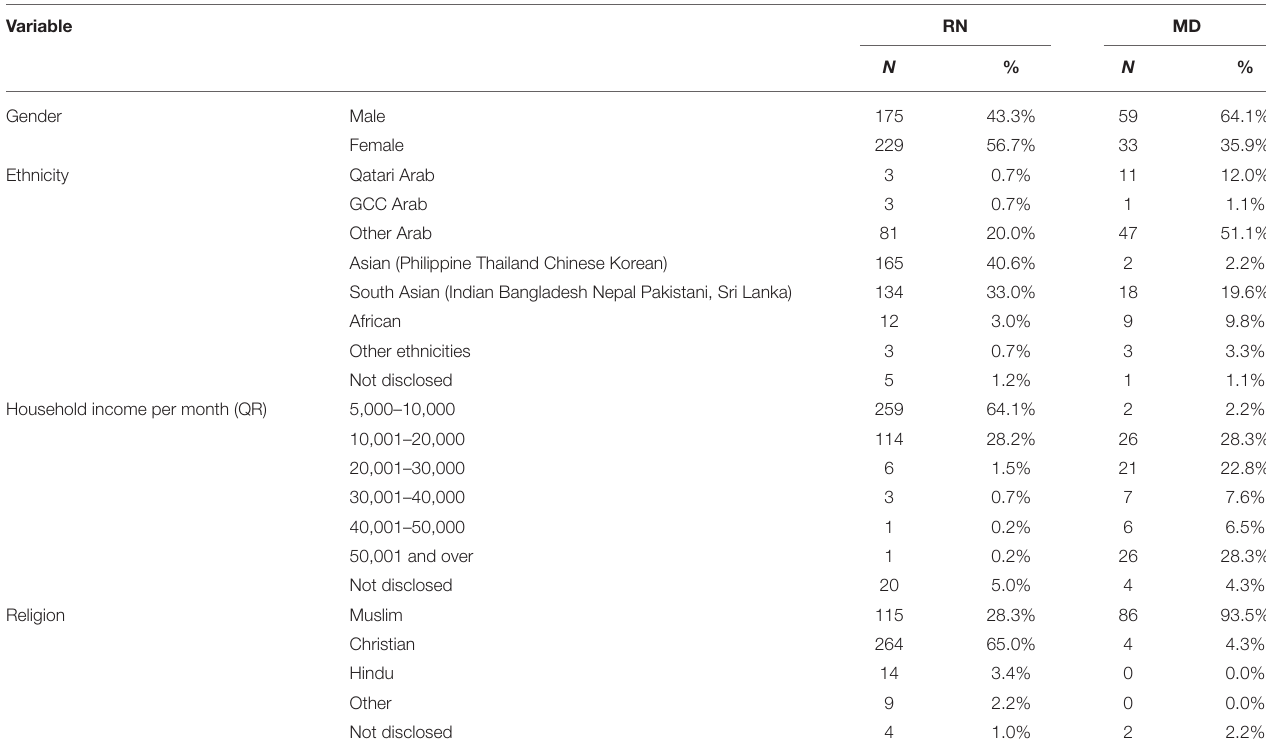
TABLE 1 | Participants’ sociodemographic background characteristics.